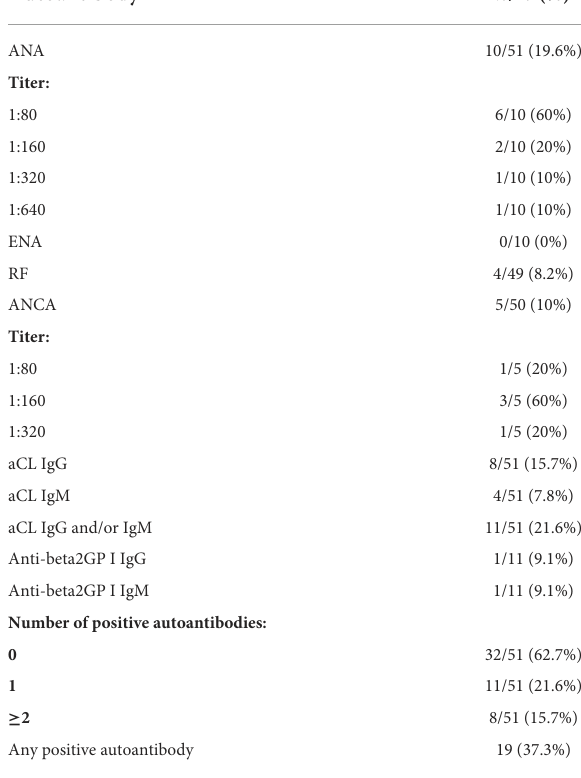
TABLE 1 Prevalence and profile of autoantibodies in the study group.